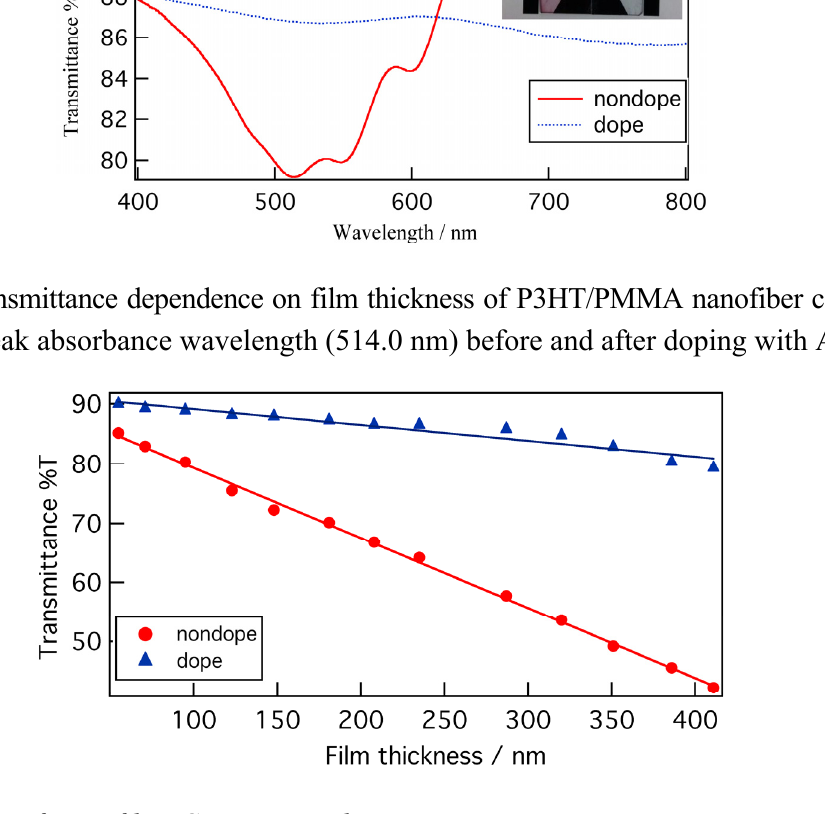
Figure 5. Transmittance spectra and photographic images of a P3HT/PMMA composite film before and after doping with AuCl . In the photographs, the red tinted left side is prior 3 to doping and the transparent right side is after doping.